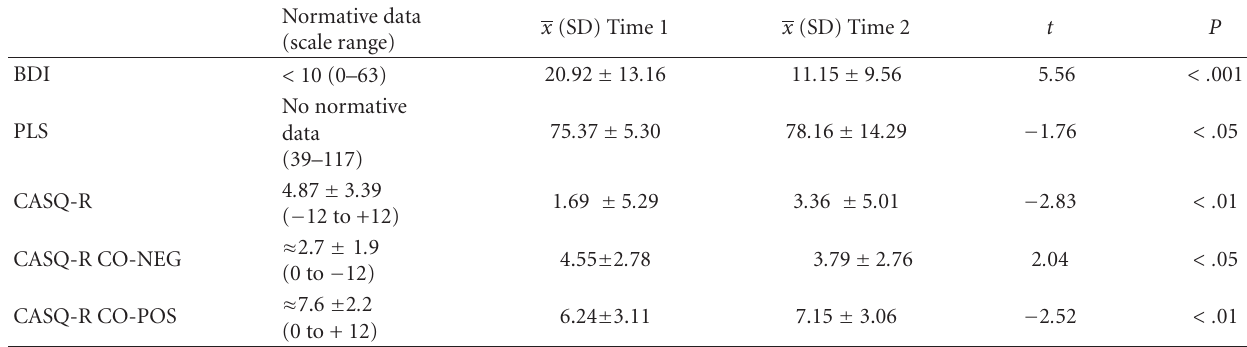
Table 4: Di ff erence over